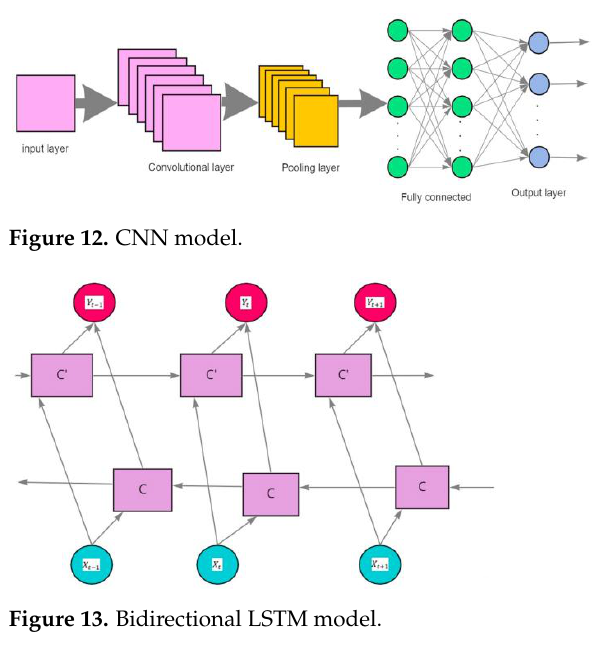
Figure 11. RNN model.